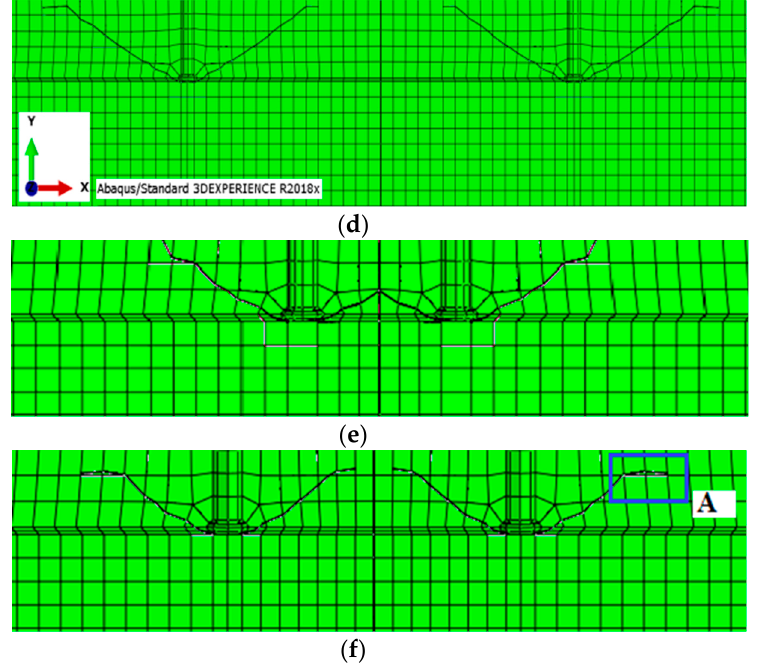
Figure 7. The anchor group effect in cone failure for a group of 2 anchors relative to anchor spacing: ( a – d ) h ef = 100 mm and the spacing s between the holes: ( a ) 100, ( b ) 150, ( c ) 200, ( d ) 300 mm, ( e , f ) h ef = 50 mm and the spacing s between the holes: ( e ) 50 mm, ( f ) 100 mm.